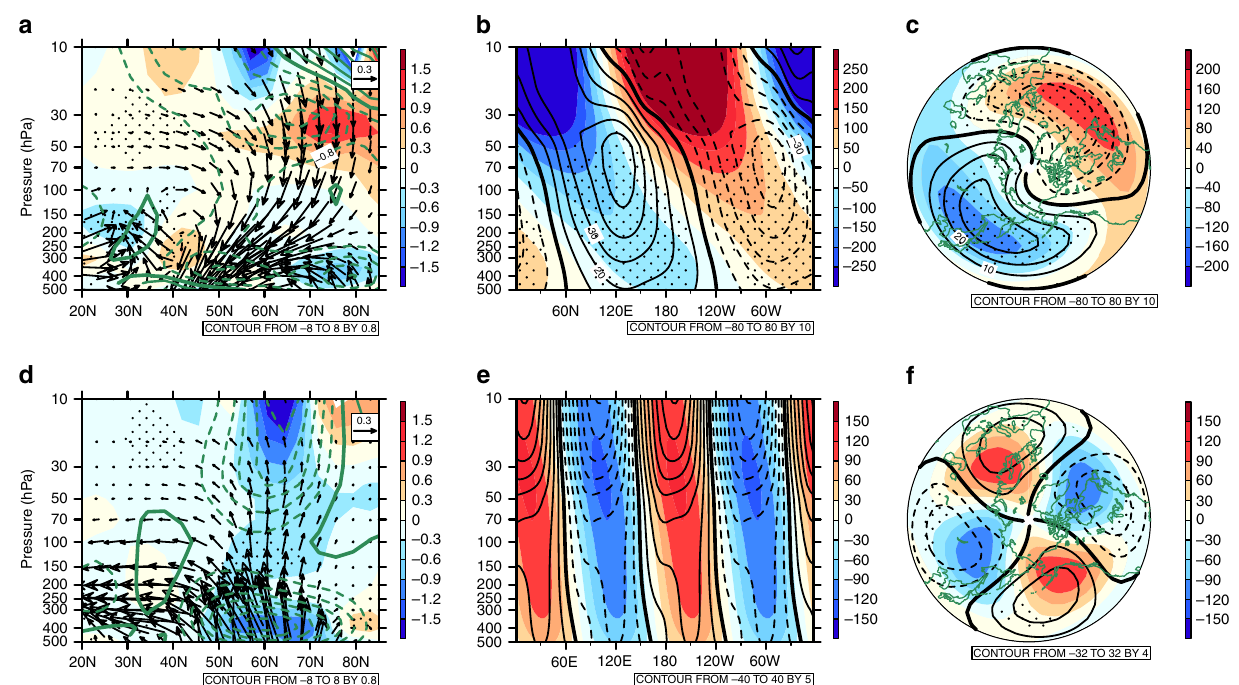
Fig. 2 Trends in the wave fl ux. The trends in the Eliassen – Palm (EP) fl ux vectors (arrows with units of 10 4 kg s − 2 decade − 1 for vertical vectors, and 10 6 kg s − 2 decade − 1 for horizontal vectors) and the EP fl ux divergence (shading) ( a , d ), the geopotential height (contours; units: gpm decade − 1 ) averaged over 45°N – 75°N ( b , e ), and geopotential height (contours) at 200 hPa ( c , f ) with wavenumber-1 wave ( a – c ) and wavenumber-2 wave ( d – f ) during 1997/98 – 2015/16 for December – January – February using MERRA. The green solid and dashed contours in a and d indicate the positive and negative divergences of the climatological EP fl ux, respectively, whereas the stippled areas in these two panels show the trends signi fi cant at/above the 95% con fi dence level. Shaded contours in b , e , c , f indicate the mean climatology of the geopotential heights